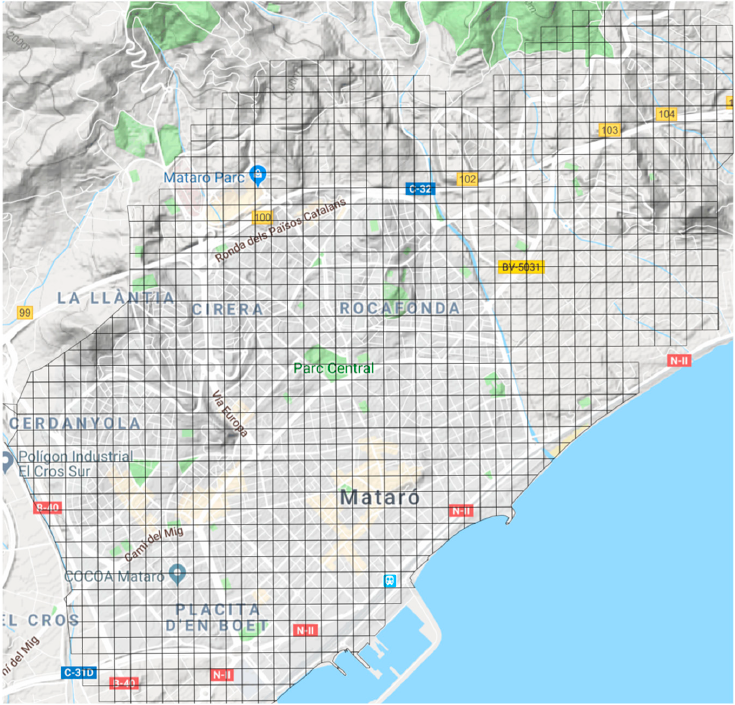
Figure 2. Sampling grids (100 m × 100 m) drawn over the Mataró map and used to sample audit grids.